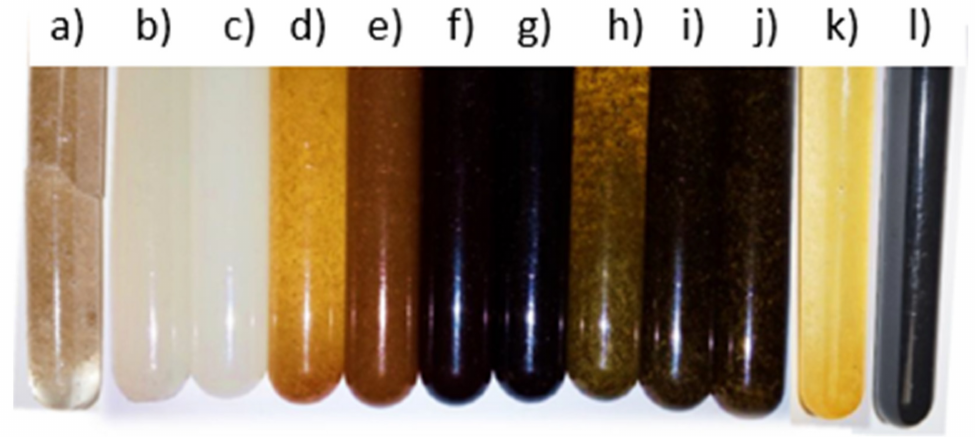
Figure 3. The pictures of obtained biocomposites. From the left with: flax ( a ), cellulose ( b , c ), oak wood flour ( d , f ), American walnut wood flour ( e , g ), horsetail ( h – j ), modified oak wood flour ( k ), modified horsetail ( l